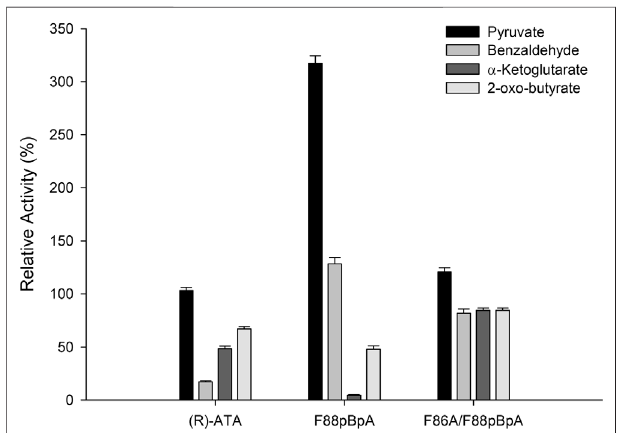
FIGURE 3 | Substrate speci fi cities of the ( R )-ATA and its variants towards various amino acceptors. ( R )-ATA activity towards pyruvate (324 mU mg − 1 ) was taken as